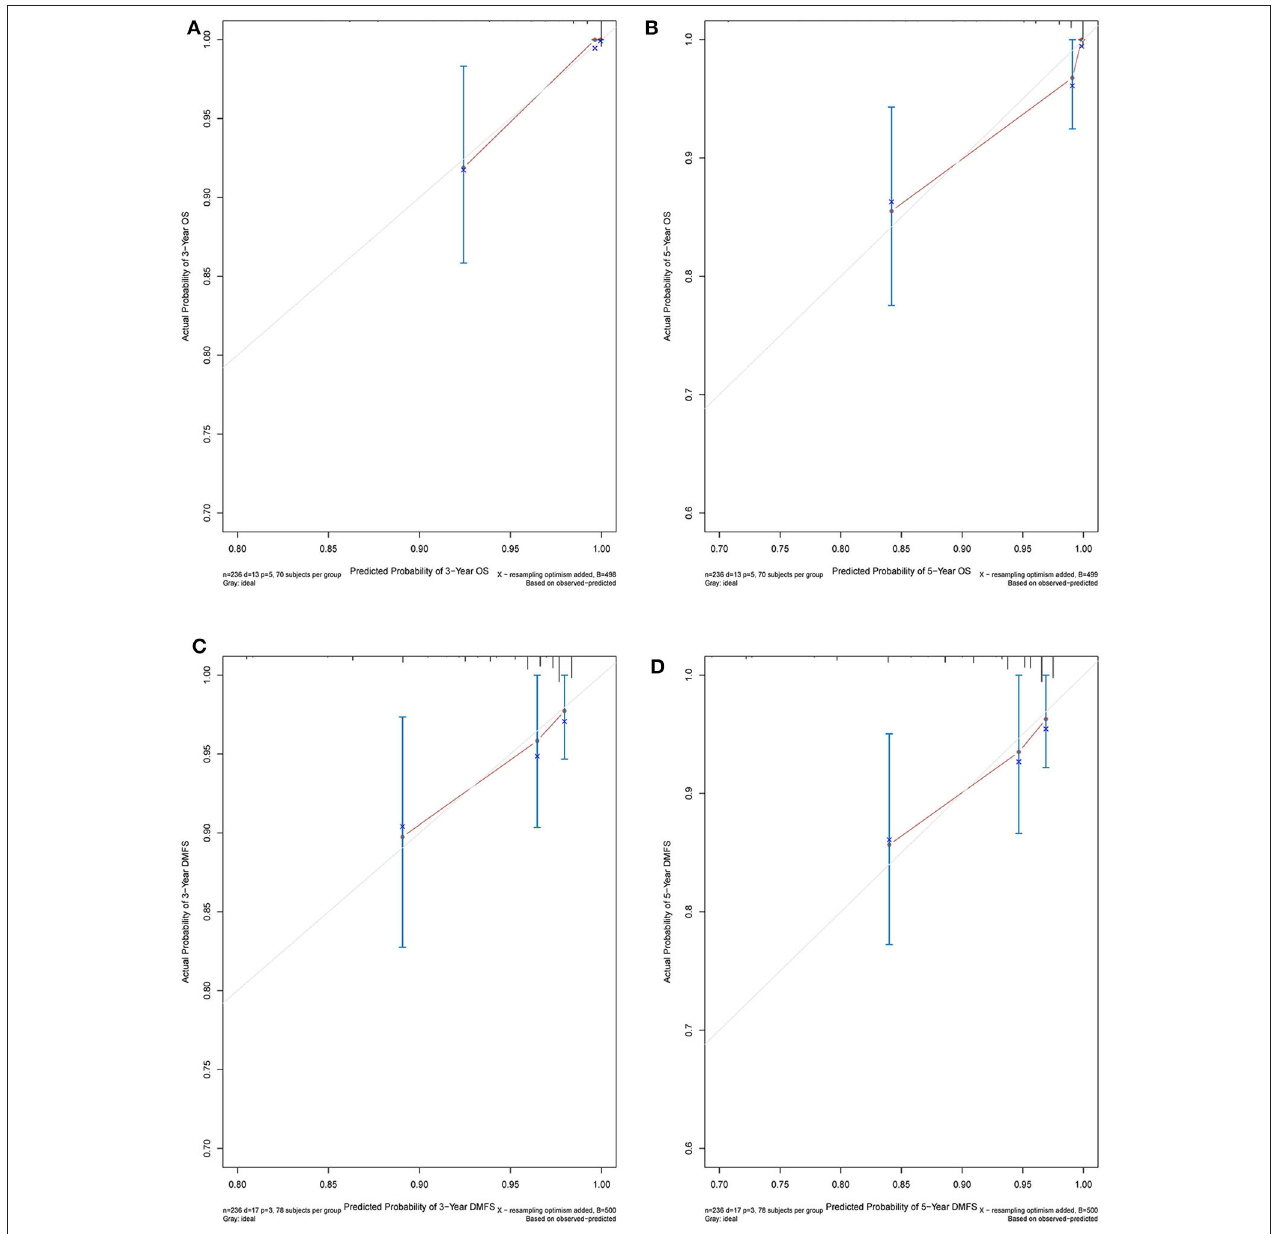
FIGURE 5 | Nomogram model calibration curves of 3-year (A) and 5-year (B) overall survival, and 3-year (C) and 5-year (D) disease metastatic free survival in the validation